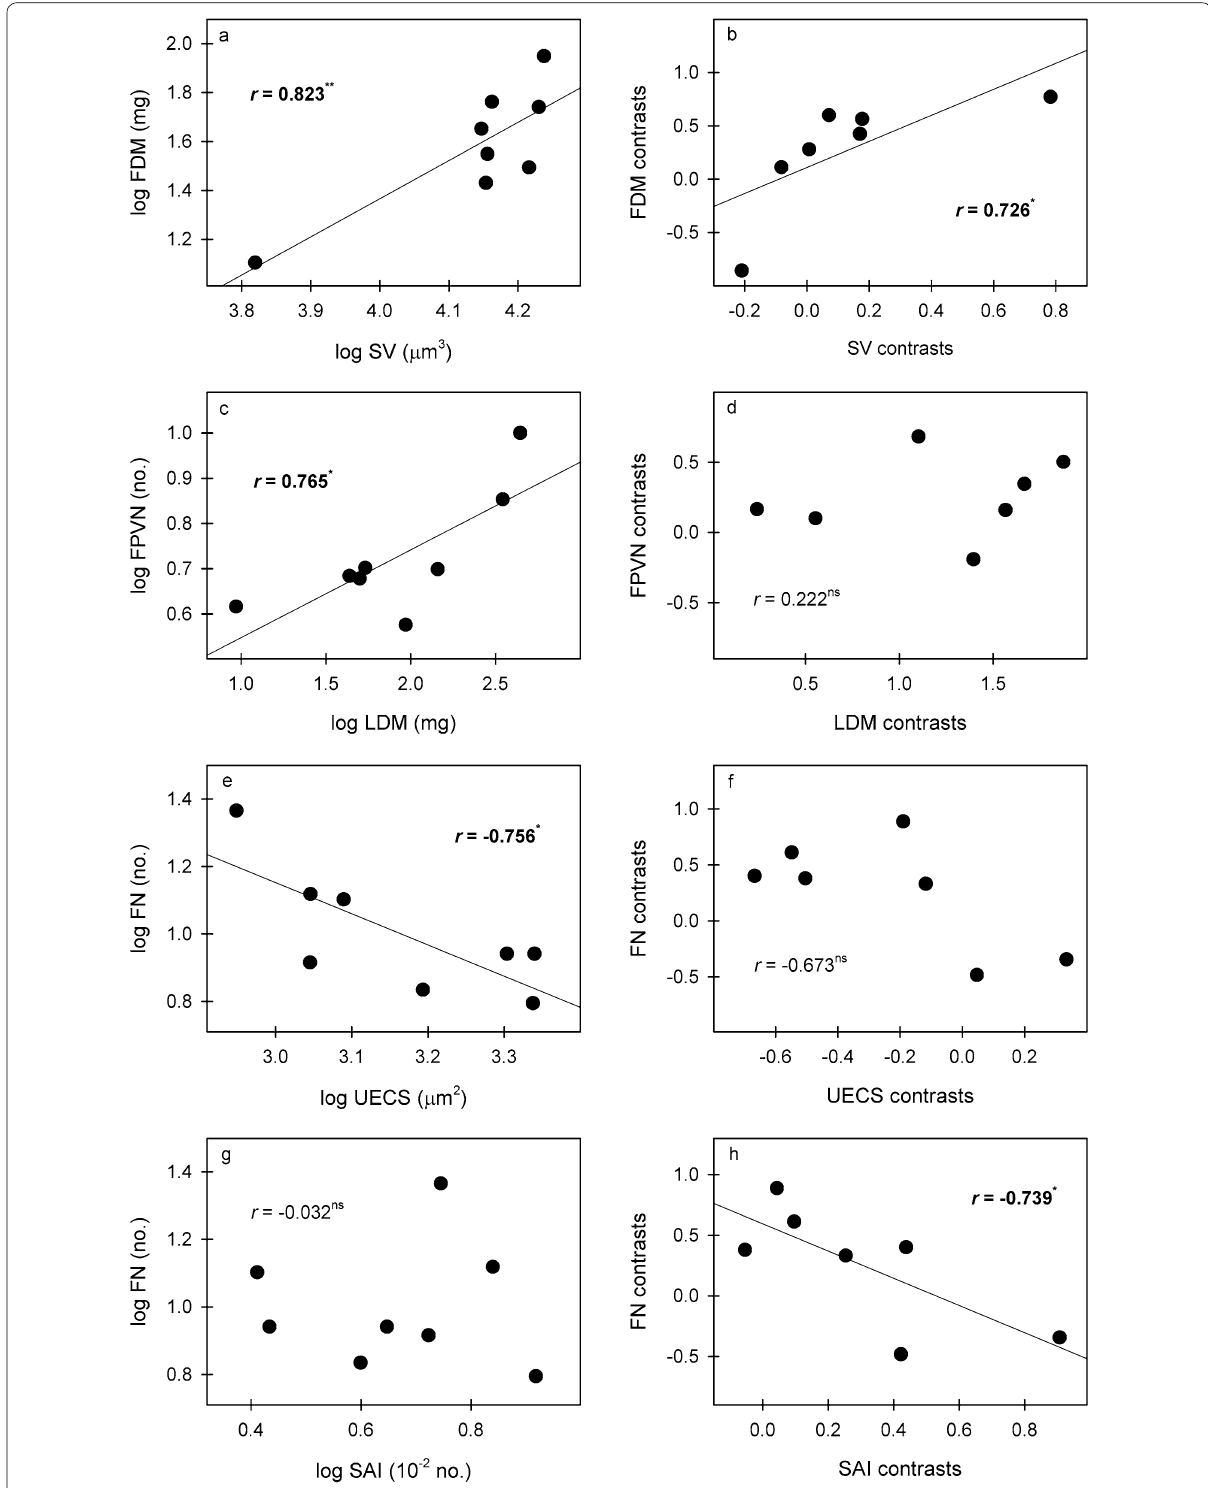
Fig. 6 Significant correlations of species mean values and PICs between leaf traits and flower traits. * p < 0.05; ** p < 0.01. LDM leaf dry mass, UECS upper epidermal cell size, SV stomatal volume, SAI stomatal area index, FDM flower dry mass, FPVN flower petal vein num ber, FN flower number per